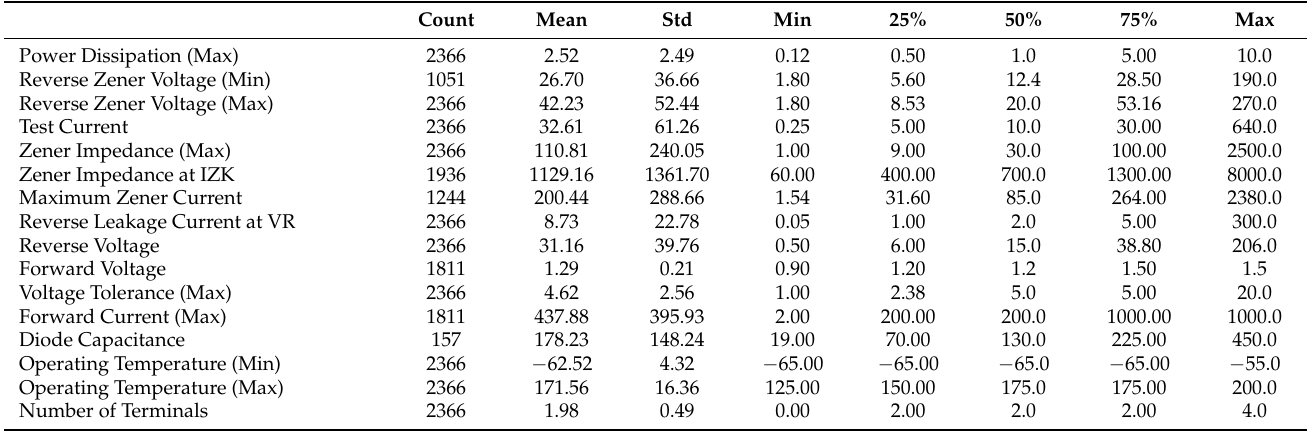
Table 3. Statistics for the features of Zener diodes.